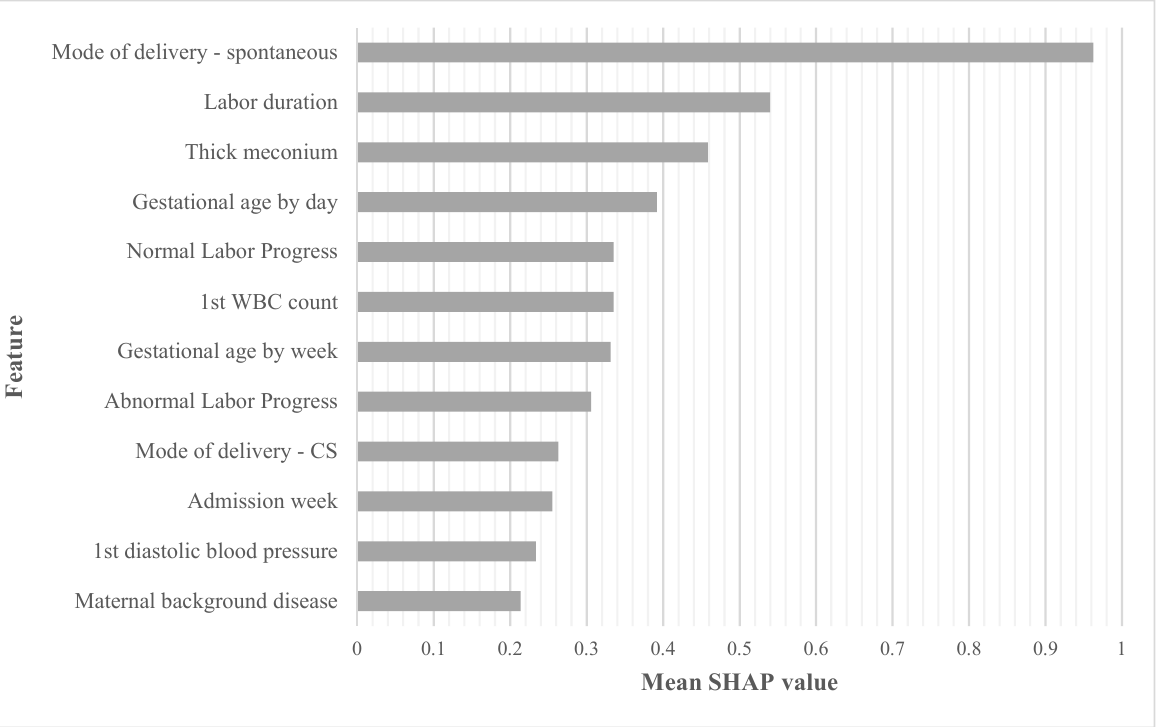
Figure 3. Risk ranking using a gradient boosting model to identify the most important influencing features in order of relative importance. The top most influential features according to the GBM, by order of importance. As seen, spontaneous delivery was the most influential feature. Values are measured by relative importance based on shapely additive explanation (SHAP). WBC, white blood cells; CS, cesarean section; SHAP, shapely additive explanation.